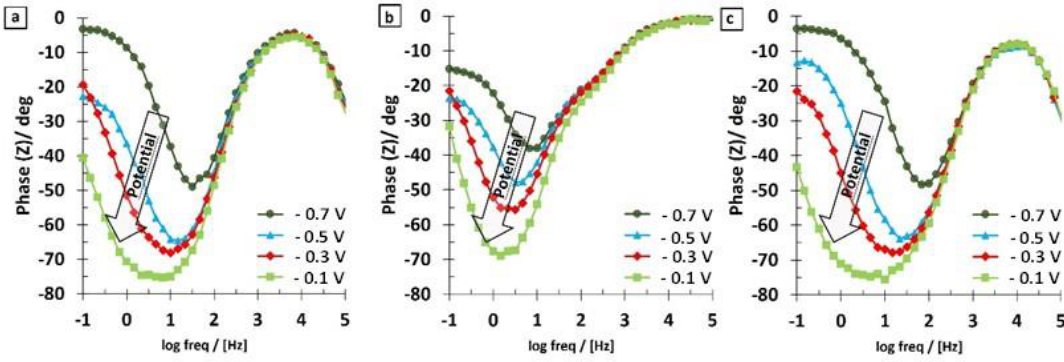
Figure 4. Bode-phase spectra at negative potentials for ( a ) Al 1.0 , ( b ) Al 0.8 , and ( c ) Al 0.6 . The Bode-phase spectra show the phase shift as a function of frequency for different potentials vs. the reference electrode. The single-phase shift peak for the potentials between − 0.7 and − 0.1 V indicates that any time constants associated with the corrosion process must be close in frequency. The maximum phase shift is centered at about 10 Hz for Al 0.8